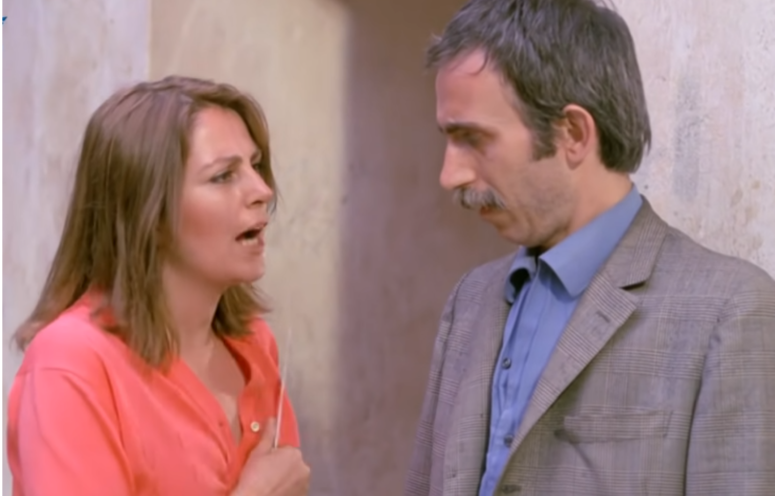
Figure 2: Aygül reprimands his husband (Macit Koper), saying she wants to divorce